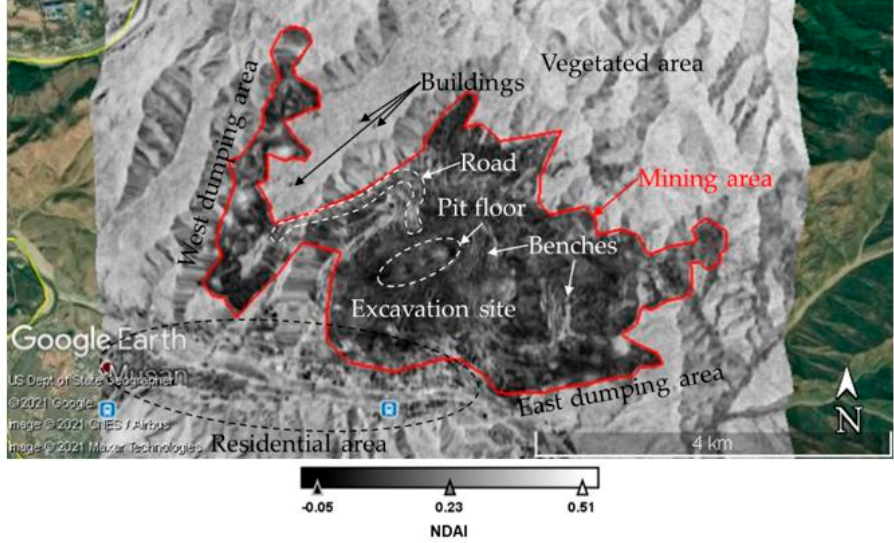
Figure 10. Overall mining activities on the averaged NDAI maps during 2015–2020. Overall NDAI is low for bare-rock-covered mining area while high in the surrounding vegetated